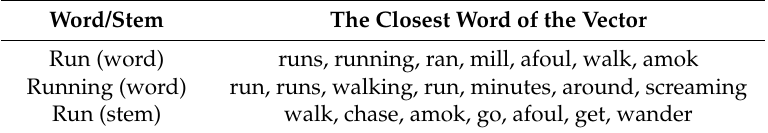
Table 2. The comparison between traditional word embedding model and the stem model regarding similar